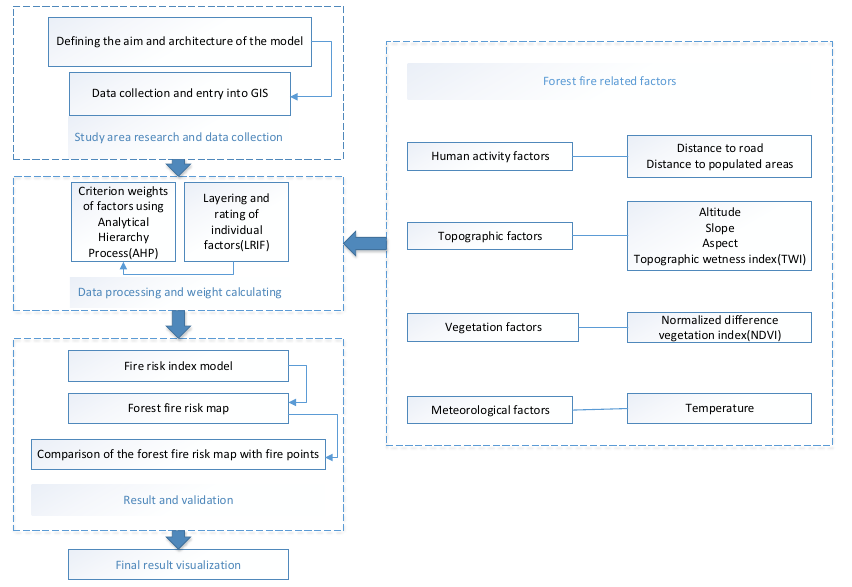
Figure 2. The process of fire risk model construction, which consists of data collection, data processing and weight calculating, result and